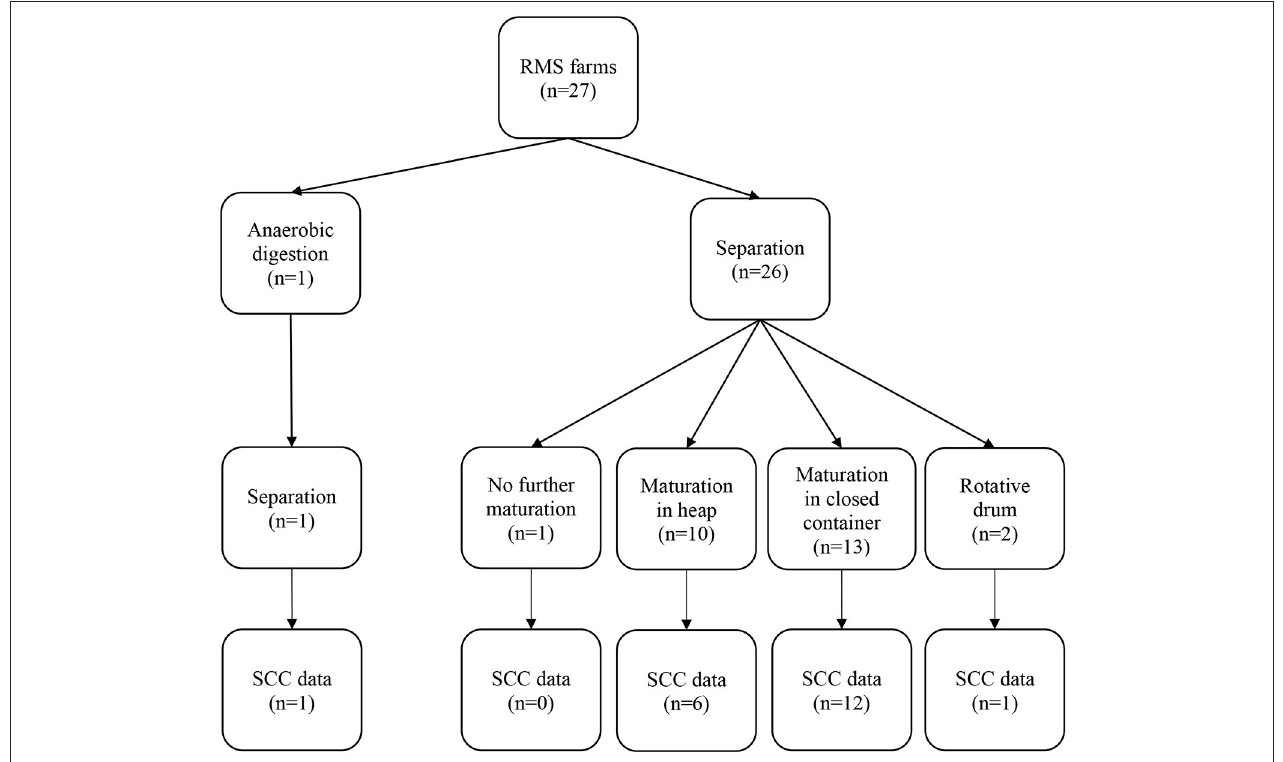
FIGURE 1 | Description of the farms’ recycled manure solids (RMS) bedding production procedures and of somatic cell count (SCC) data